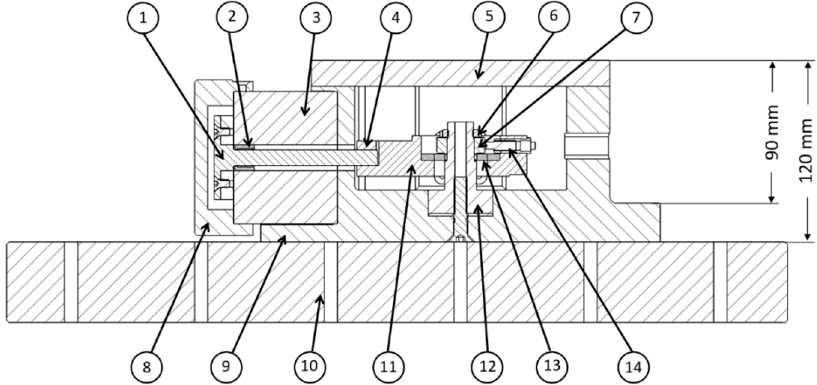
Figure 3 . Cross-section of the machine from lateral view. (1) Mobile part of the actuator. (2) Collet for actuator support. (3) Static part of the actuator. (4) Screw to fix actuator to the machine. (5) Plexiglass cover. (6) Top nut. (7) Metallic spacer. (8) Metallic cover of the actuator. (9) Body of the machine. (10) Seismic mass. (11) External support of the damper. (12) Internal support of the damper tower. (13) Viscoelastic damper. (14) Displacement sensor.